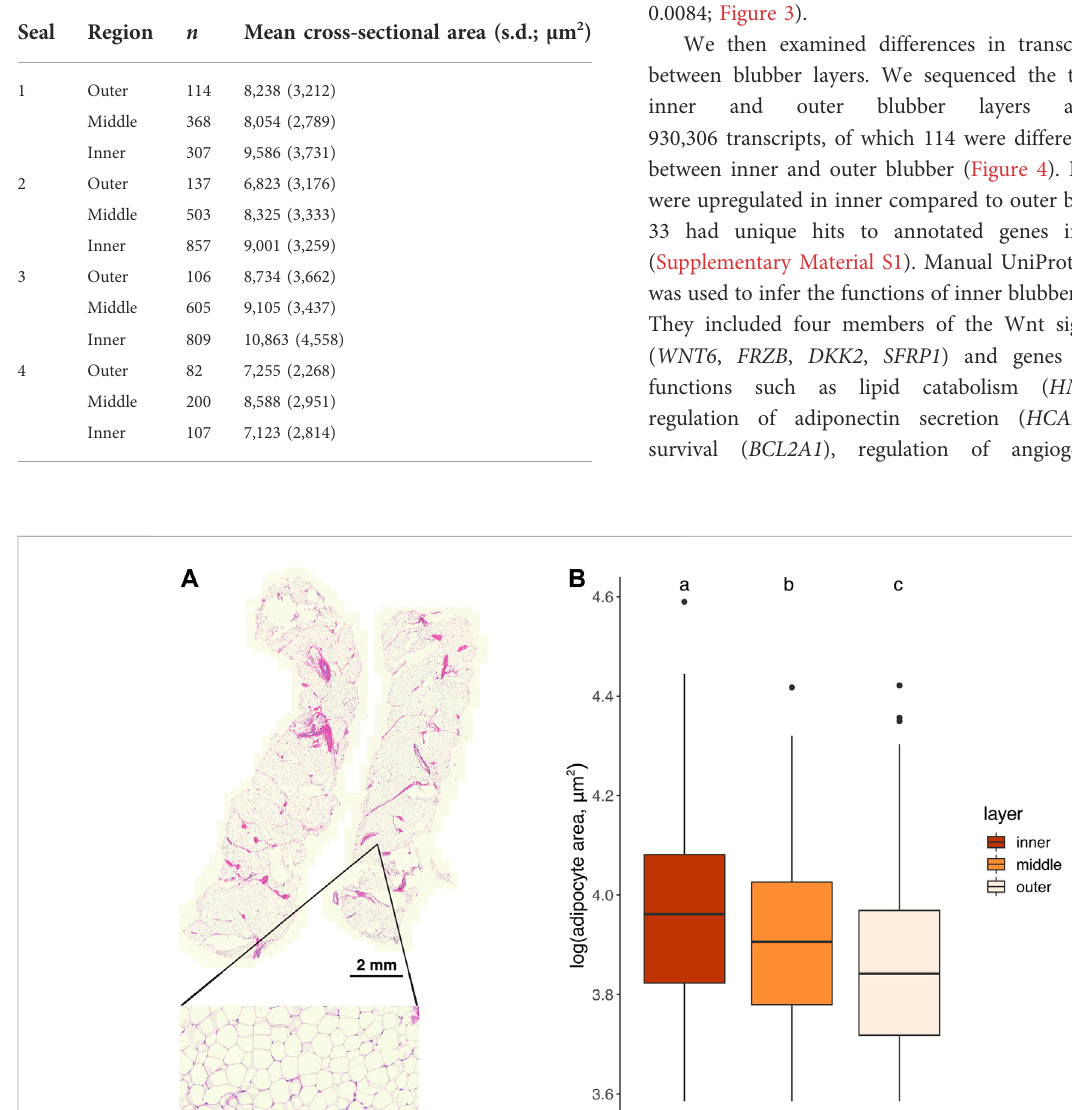
TABLE 2 Number of adipocytes measured ( n ) and mean (±s.d.) cross- sectional areas of adipocytes in outermost (skin-adjacent), middle, and innermost (muscle-adjacent) blubber regions of juvenile northern elephant seals ( n = 4).